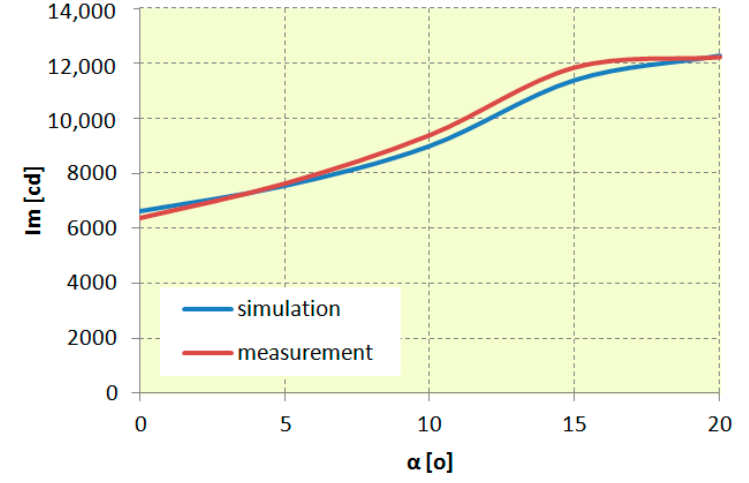
Figure 23. The comparison of maximum luminous intensity of a light-optical system obtained as a result of simulation and prototype measurements in the function of reflector’s inclination angle.